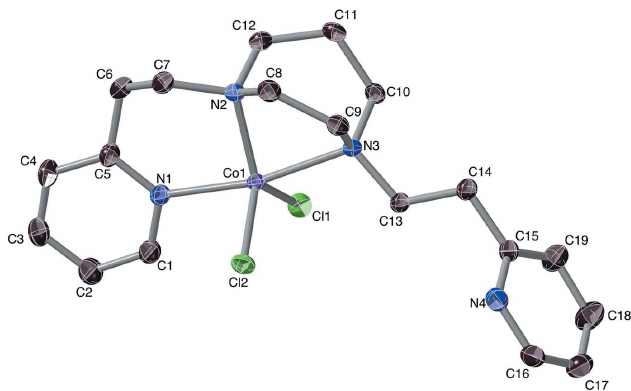
Figure 3 Structure of Co(Phpz)Cl 2 , with its dangling pyridine moiety. The dominant conformer is shown. Ellipsoids are drawn at the 50% level, and for clarity of presentation, H atoms are omitted.